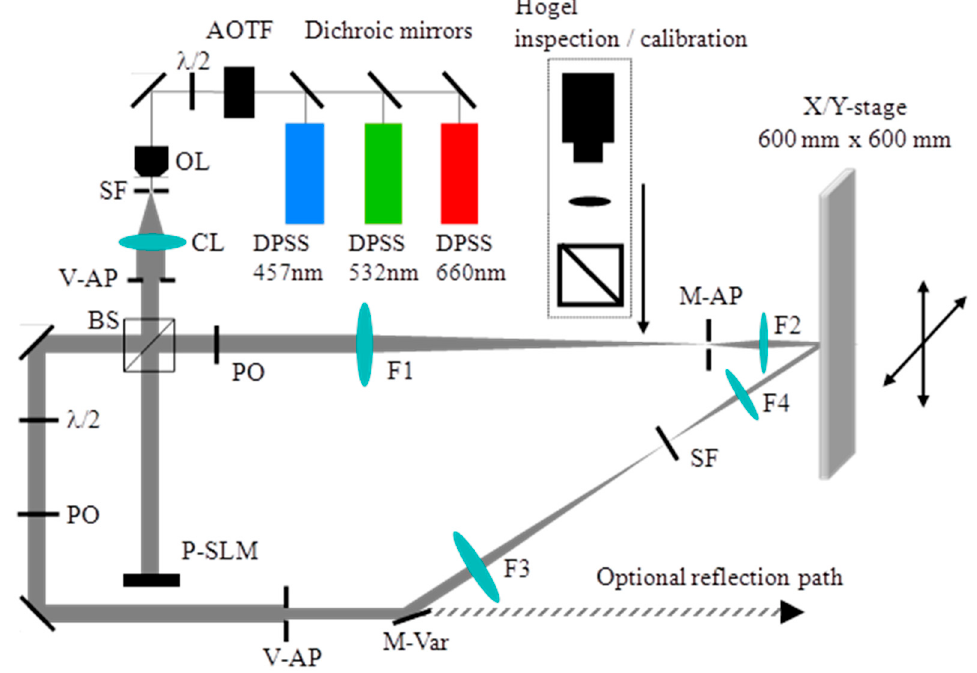
Figure 18. Setup of the holographic printer in which a 600 mm × 600 mm large CGH can be exposed [57].